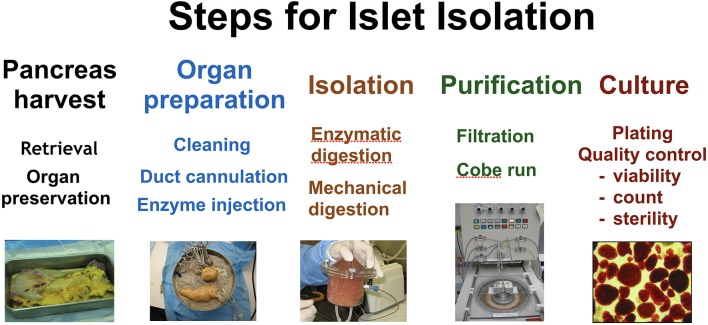
The major steps undertaken in islet isolation. From left to right; pancreas harvest, organ preparation, isolation, purification, and culture.